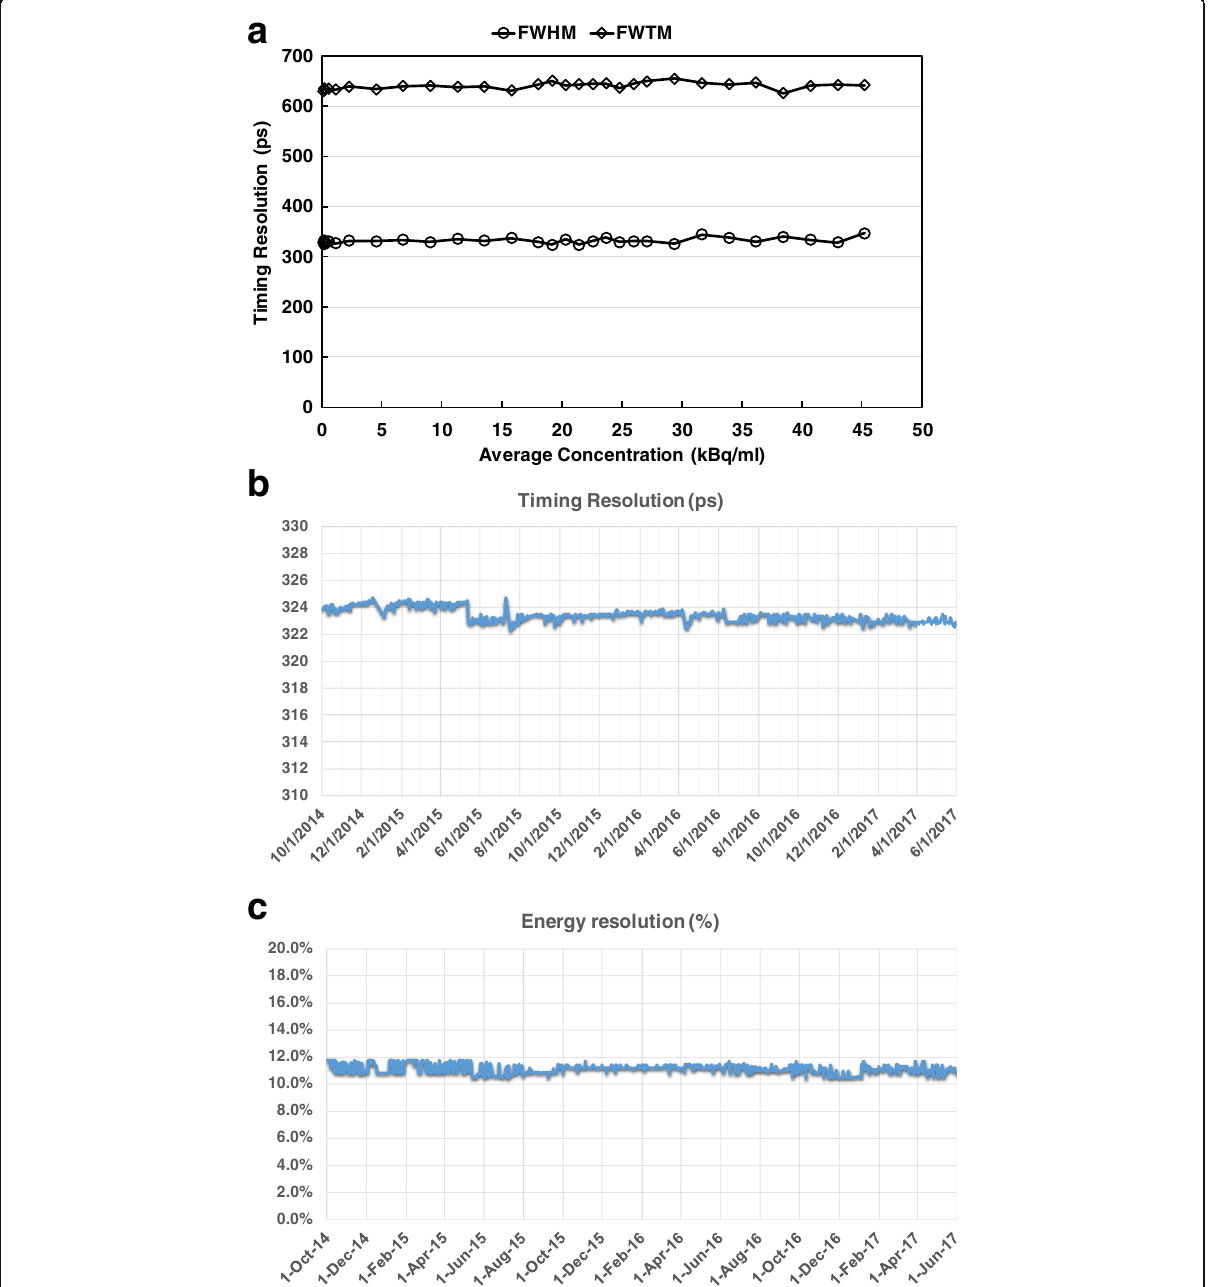
Fig. 7 Timing resolution and energy resolution of the dPET system. a NEMA NU2-2018 timing resolution in FWHM and FWTM as a function of activity concentration. b Stability of timing resolution ( 22 Na point source based) within the 31-month monitoring time window. It demonstrates a slight improvement from 325 ps to 322 ps when system calibration was performed 6 months after installation. c Stability of energy resolution during the monitoring time